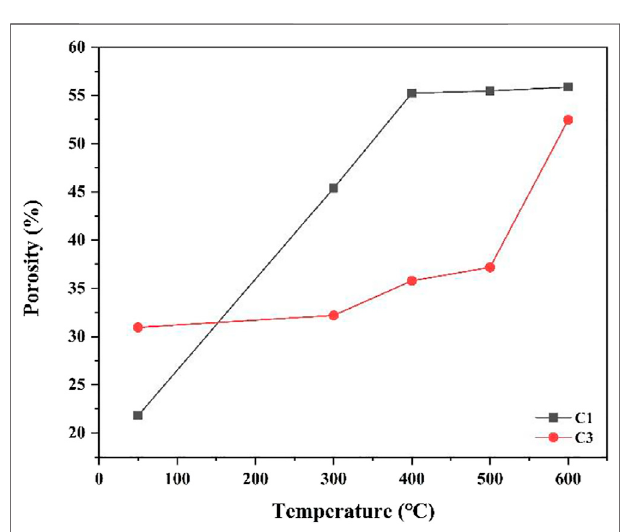
FIGURE5| PorositydiagramofC1andC3cementpastesaftercuringat different temperatures.